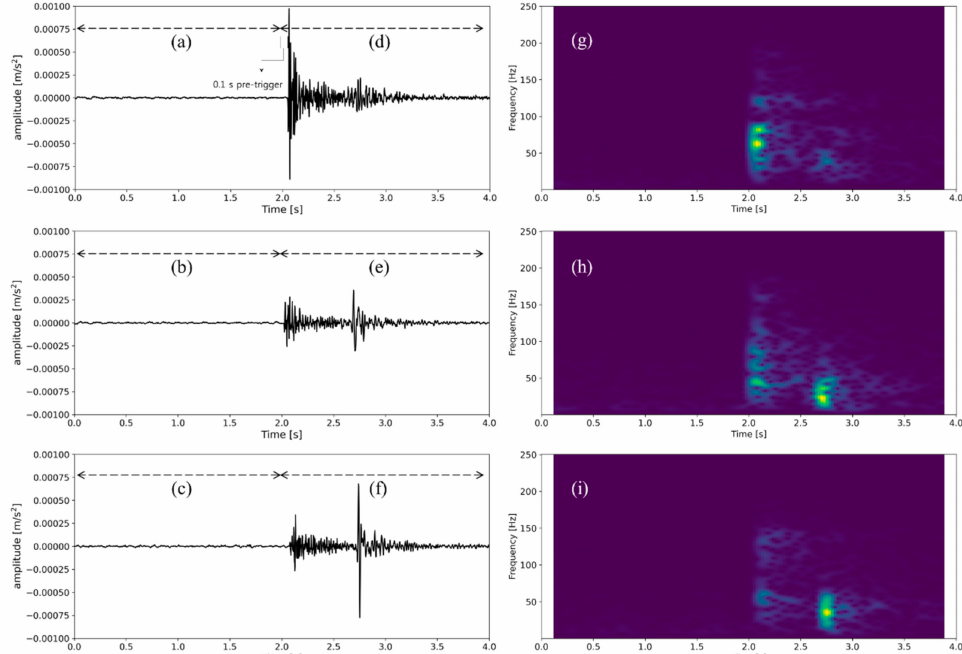
Figure 4. The example of the PHBS8 data and their time-frequency spectrograms: vertical, horizontal 1, and horizontal 2 in order from top to bottom. ( a – c ) Noise and ( d – f ) signal examples generated from the same microseismic event. In this study, noise and signal are labeled with 1 and 0, respectively, which means the closer to 0 an output of machine or deep learning, the higher its possibility to be signal. ( g – i ) show spectrograms of each vertical, horizontal 1, and horizontal 2, which shows the actual frequency range of ( a – f ) The microseismic data was split into noise and signal based on the 0.1 s before P-wave onset time calculated from the STA/LTA algorithm. The total length of the data was 2 s; thus, 1001 data points were generated under the acquisition condition of 500 data points per